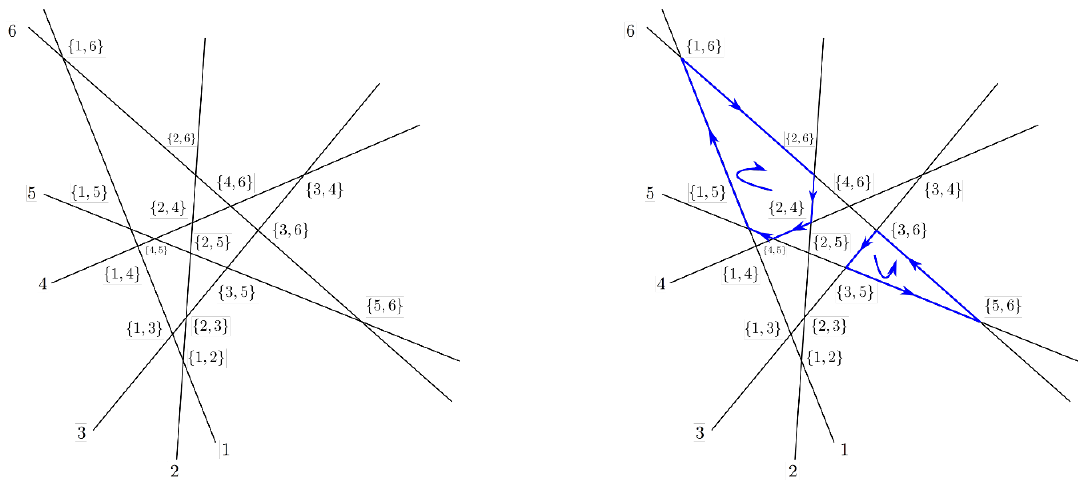
Figure 6 . A general polygon (right) de(cid:12)ned solely through a set of instructions for traversing the intersections of six lines (left). Lines are labeled by i according to the Z (cid:11) the intersection of two lines i and j is denoted by f i; j g . It is implied that f i; j g = f j; i g